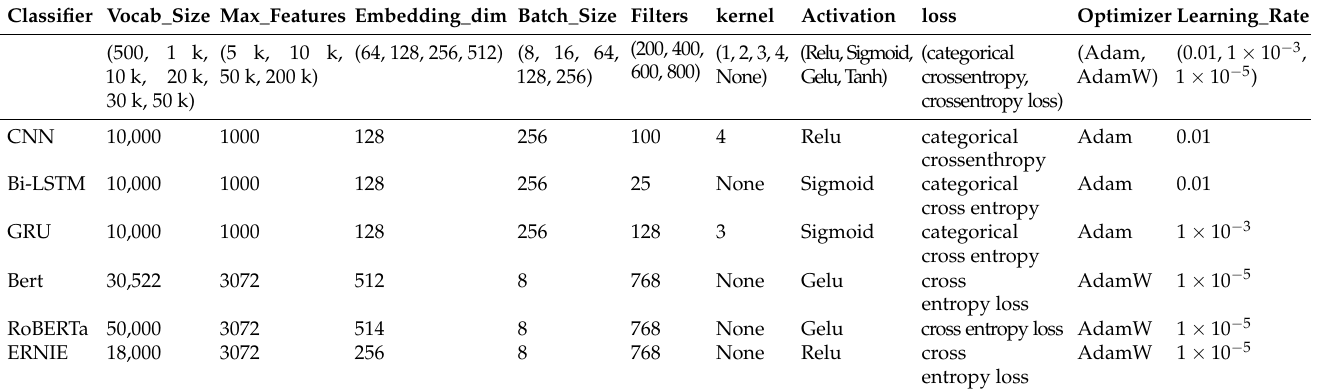
Table 3. Selected Parameters.